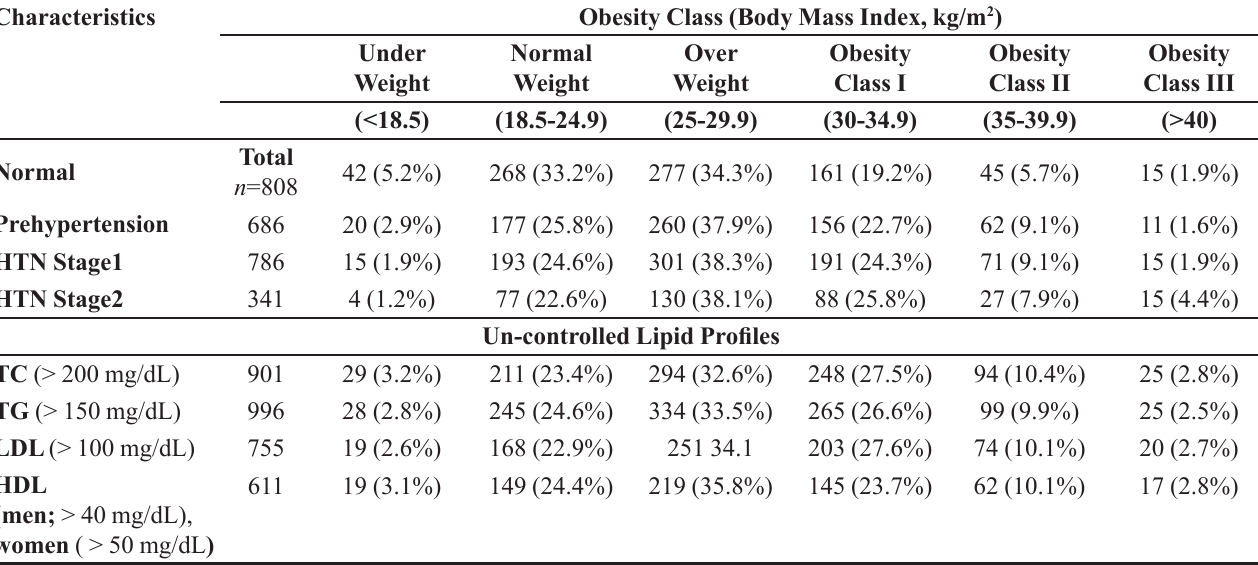
TABLE III - Hypertension stages and un-controlled lipid profiles according to patient’s body weight and obesity class measurements